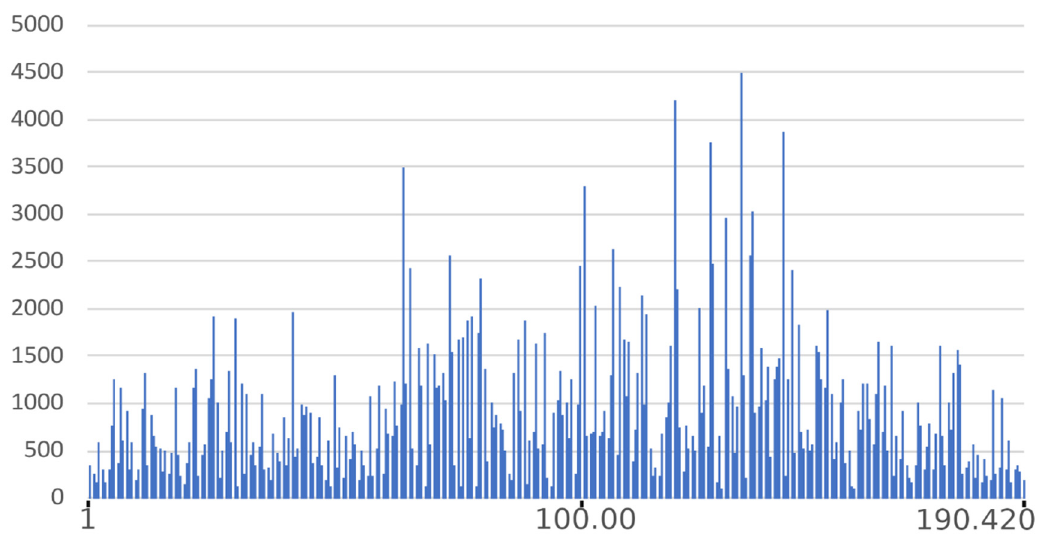
Figure 2. Read-length distribution of LoRTIA transcripts along the ASFV genome.